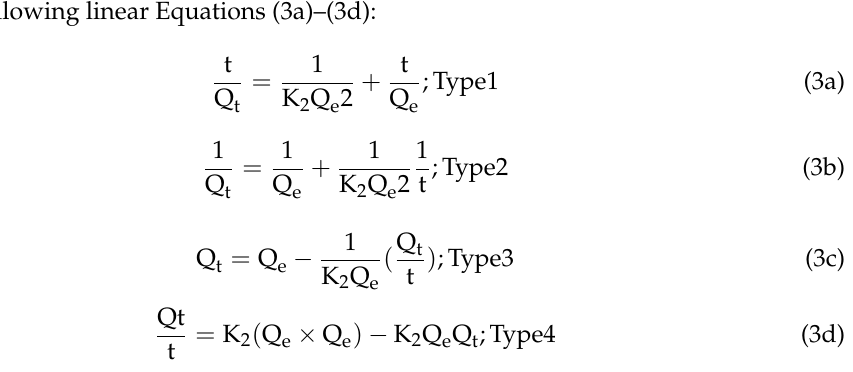
Figure 1. Experimental data of contact time between AB 113 onto IRA 402 mass. The values are the average of three replicates with RSD% below 8% for all experiments. The behavior of the reaction rate can be analyzed using kinetic adsorption models. The kinetic trend was determined by fitting the adsorption capacity (Q t ) vs. the adsorption time (t) in Figure 1. From this investigation, Q t was calculated with the following equation (eq):